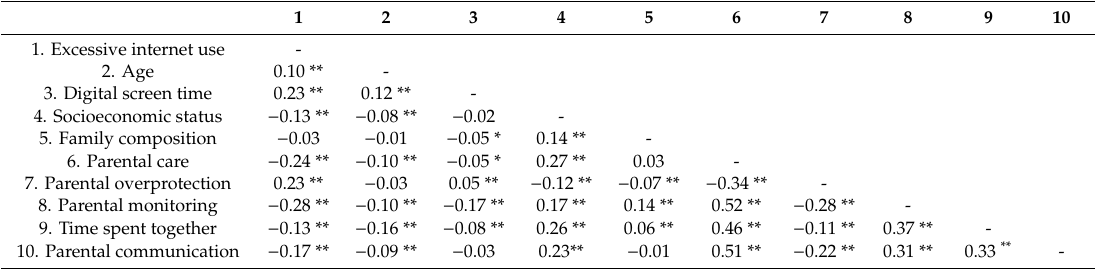
Table 2. Spearman´s rank correlations of all study